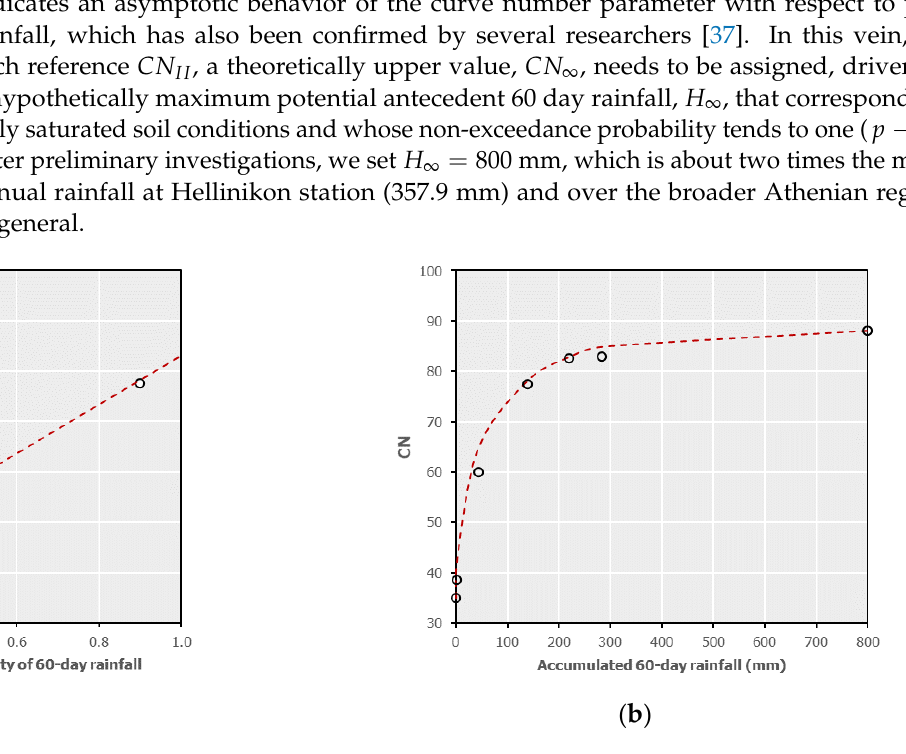
Figure 5. Example of adjusting reference CN II = 60: ( a ) mapping to non-exceedance probability of 60 day rainfall through the probabilistic function (4); ( b ) mapping to 60 day rainfall through the generalized formula in Equation (5).